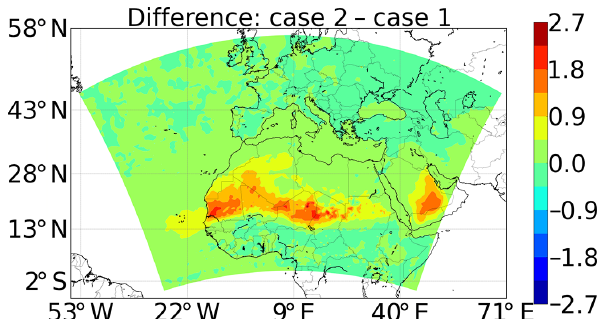
Figure 8. CHIMERE mineral dust emission fluxes (in gm − 2 s − 1 ) averaged over the period ranging from 1 June to 14 July (online case 1 simulation).